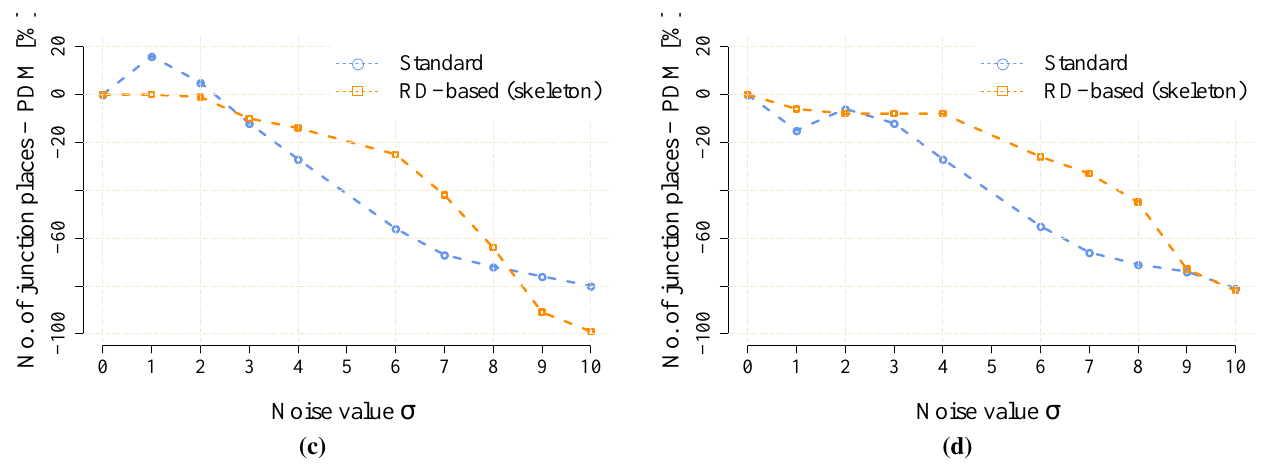
Figure 18. The noise sensitivity indicator JPDM Equation (3) in the scaled noisy maps of the cube environment. ( a ) cube 283 × 419; ( b ) cube , 354 × 524; ( c ) cube , 401 × 593; ( d ) cube , 472 × 698.